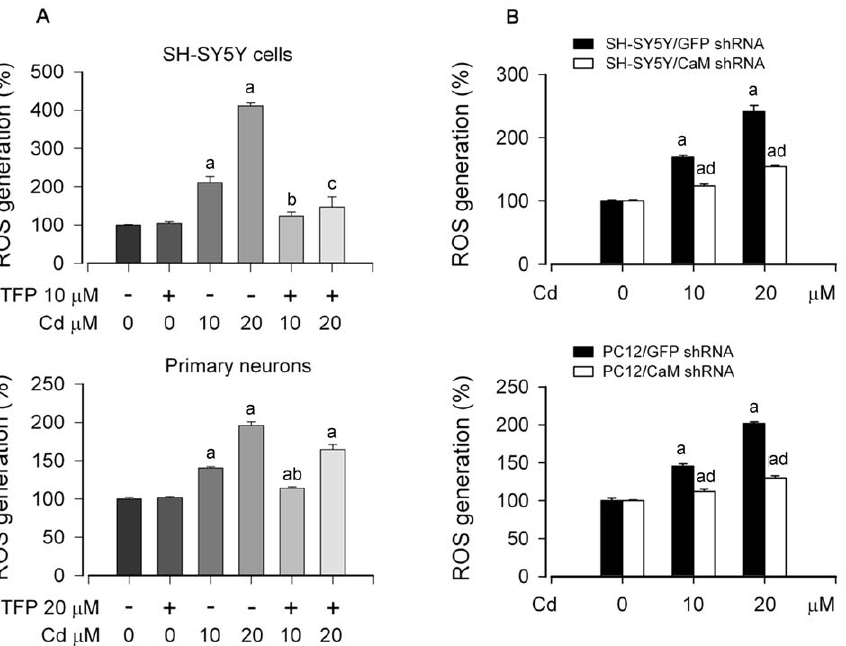
Figure 7. CaM is essential for Cd induction of ROS in neuronal cells. Indicated cells pretreated with/without TFP at indicated concentrations for 30 min (A), or infected with lentiviral shRNAs to CaM and GFP, respectively (B), were exposed to 0–20 m M Cd for 24 h, followed by ROS detection, as described in Materials and Methods. Results are presented as mean 6 SE; n =6. a P , 0.01, difference vs. control group; b P , 0.01, difference vs. 10 m M Cd group; c P , 0.01, difference vs. 20 m M Cd group; d P , 0.01, CaM shRNA group vs. GFP shRNA group.